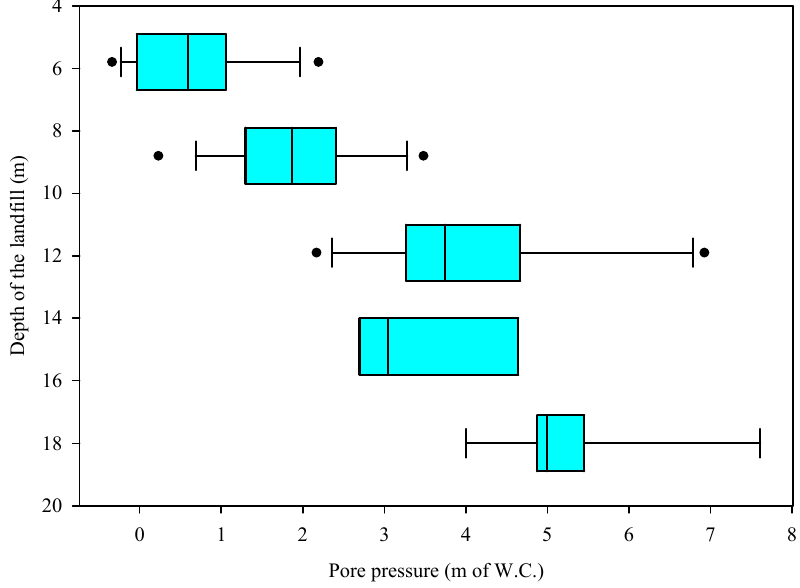
Figure 3. Pore pressures measured by the piezometers at various depths inside the landfill prior to leachate